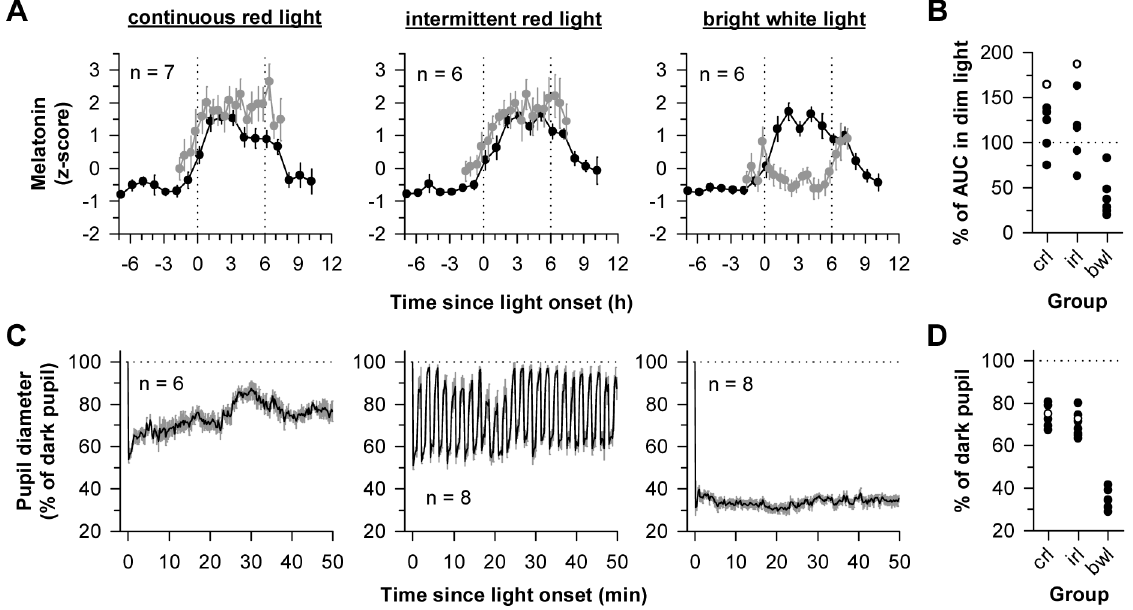
Figure 4. Melatonin levels and pupillary constriction during nocturnal light exposure. ( A ) Melatonin profiles are shown for participants exposed to 6 h of continuous red light (left), intermittent red light and darkness (center), or bright white light (right) near the onset of melatonin secretion. Black traces show the melatonin rhythm on the day prior to light exposure, and gray traces show melatonin on the day of the light exposure session. Melatonin concentrations during light exposure were individually adjusted using Z-score values obtained during the first constant routine procedure. Vertical dotted lines indicate the onset and offset of the light exposure session. ( B ) The area under the curve (AUC) of the melatonin profile during light exposure is shown for each subject, expressed as a percentage of his AUC measured in dim light. Values less than 100% therefore indicate light-induced melatonin suppression, whereas values that exceed 100% indicate that the AUC was higher during the light exposure session relative to the AUC measured in dim light on the previous day. The open circles show responses for subjects crl30 and irl31 , who exhibited substantial resetting of circadian rhythms, as shown in Figure 3. ( C ) The pupillary light reflex is shown during the first 50 min of exposure to continuous red light (left), alternating red light and darkness (center), and bright white light (right). ( D ) The median pupillary light response is shown for individual subjects during the 50-min fixed gaze period, expressed relative to the dark pupil. Horizontal dotted lines in C and D indicate pupil diameter in darkness, and data in C are binned at intervals of 15.625 s, corresponding to one-quarter of an intermittent lights-on pulse. In A and C , the mean 6 SEM is shown. In B and D : crl, continuous red light; irl, intermittent red light; bwl, bright white light.